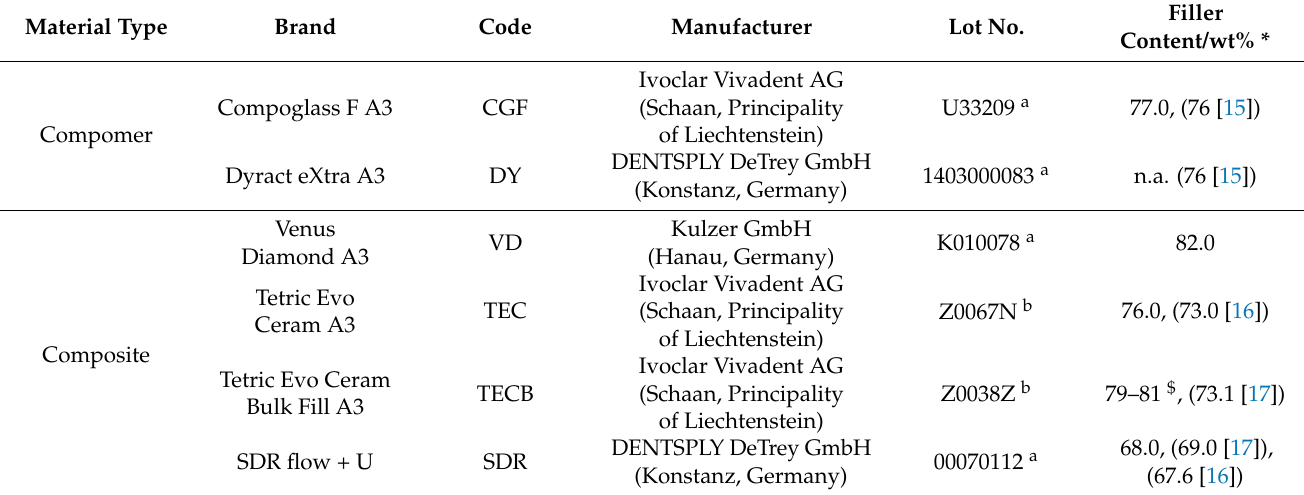
Table 1. Materials